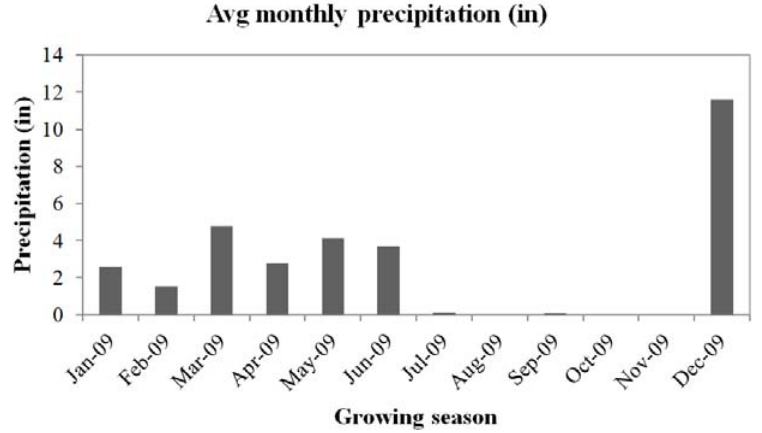
Figure 3. Annual precipitation during the experimental year in inches during the eggplant growing period in the Piedmont region of North